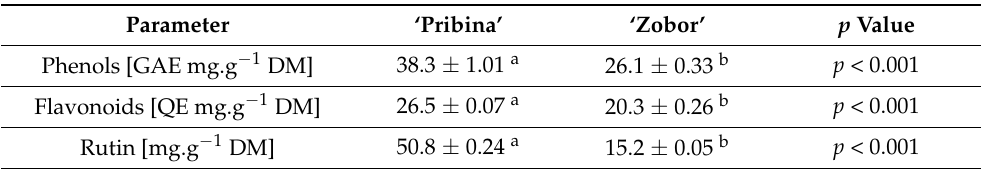
Table 2. Content of total phenolic, flavonoids and rutin in ethanol leaf extracts of two amaranth varieties—‘Pribina’ and ‘Zobor’. Parameter